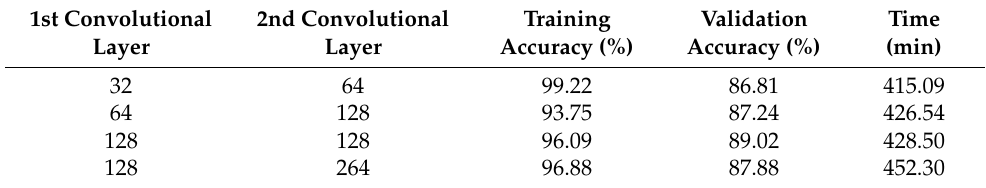
Table 7. Training and validation accuracy of different convolution filter numbers.